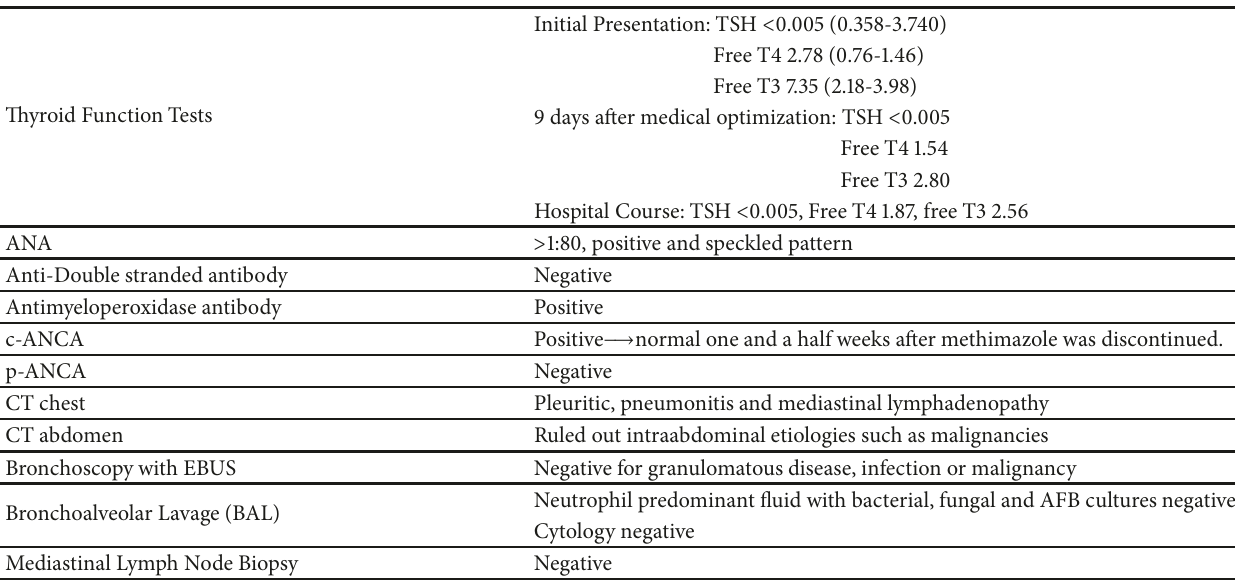
Table 1: Detailed laboratory and procedures.